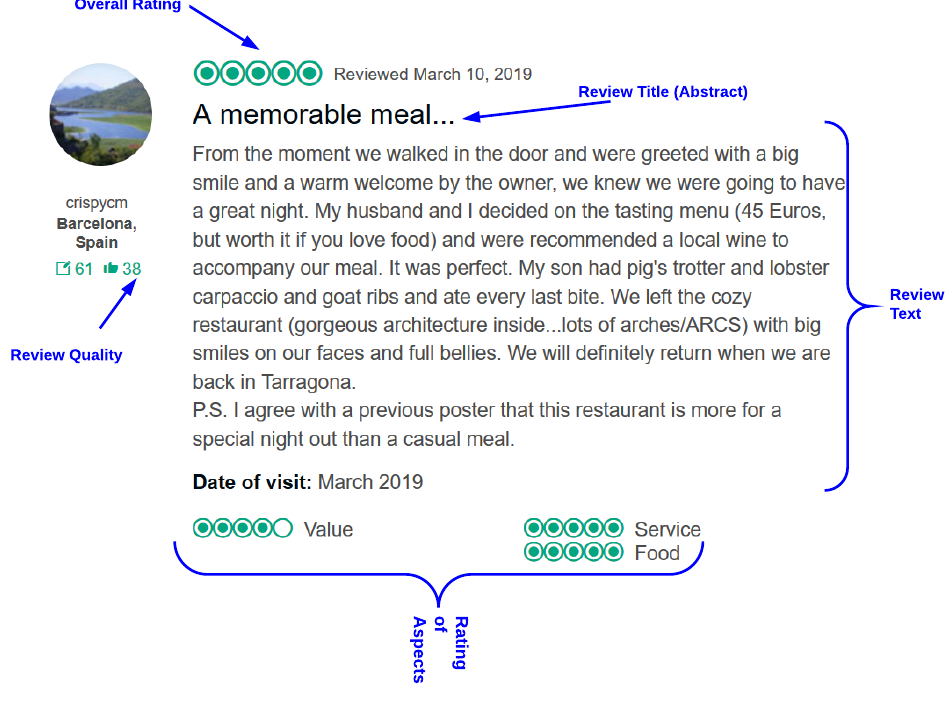
Figure 1. Components of the review of a